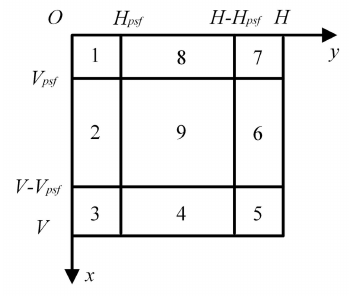
Figure 4 . Regions of window function (Wang et al. , 2018) The window function in different regions corresponds to